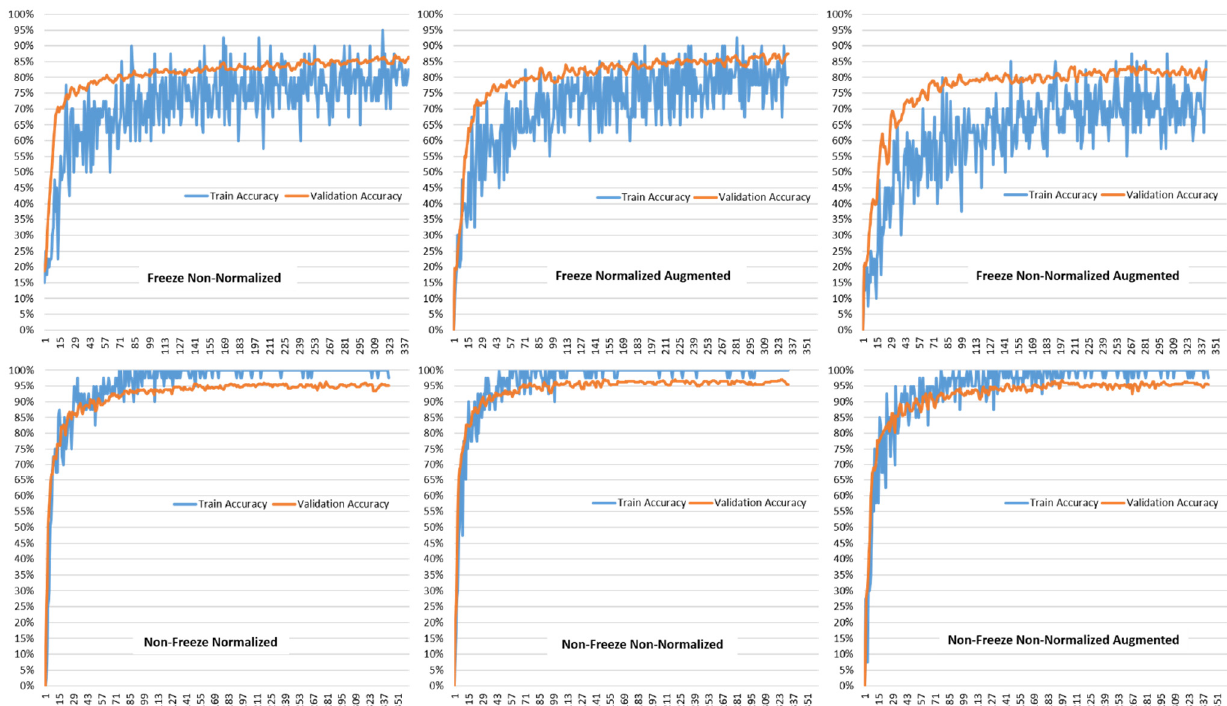
Figure 5. Comparison of Train Accuracy and Validation Accuracy for different model setups for VGG19-based Transfer Learning.